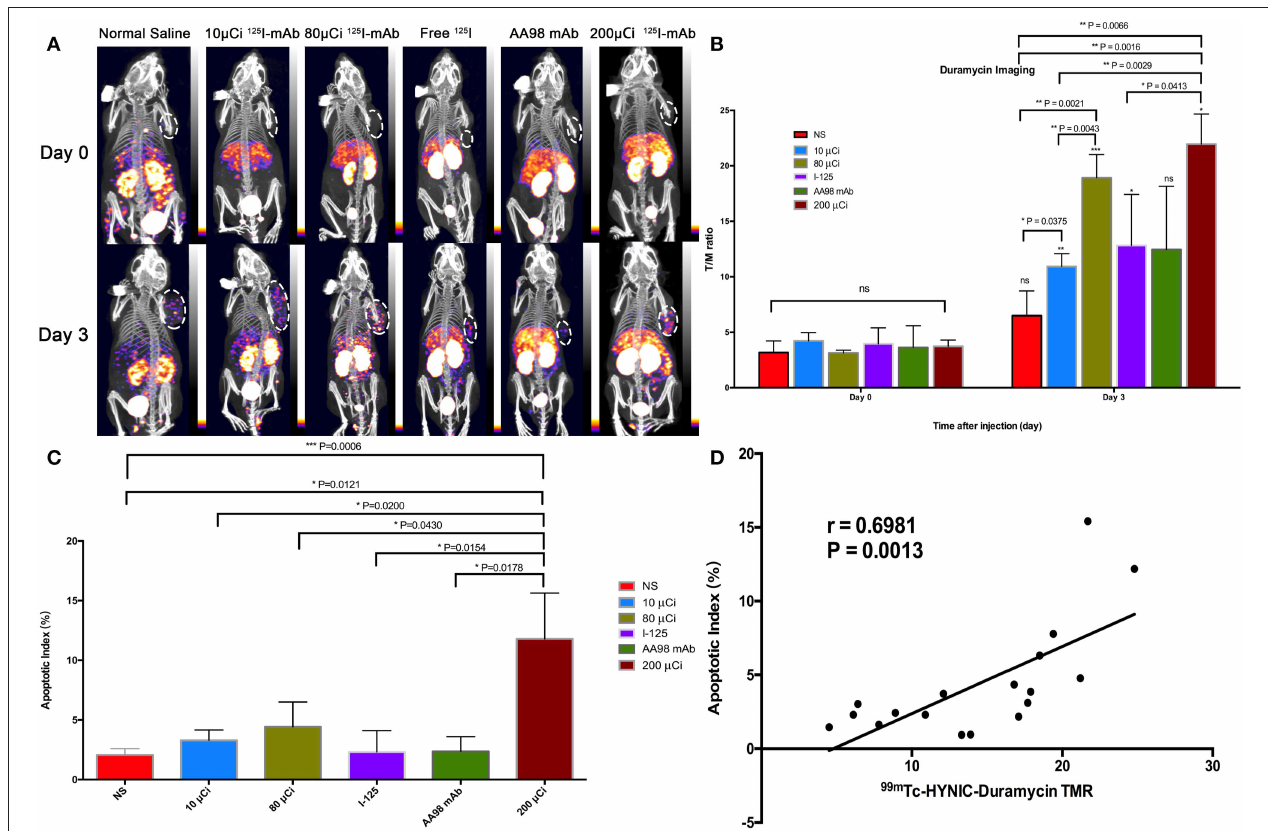
FIGURE 1 | In vivo SPECT/CT imaging with 99m Tc-HYNIC-Duramycin and apoptosis immunofluorescence staining in HCC xenograft mice models. Tumor images were obtained with SPECT/CT before (upper row) and 3 days after (bottom row) intratumoral injection among the six groups (A) . (B) T/M ratio was analyzed